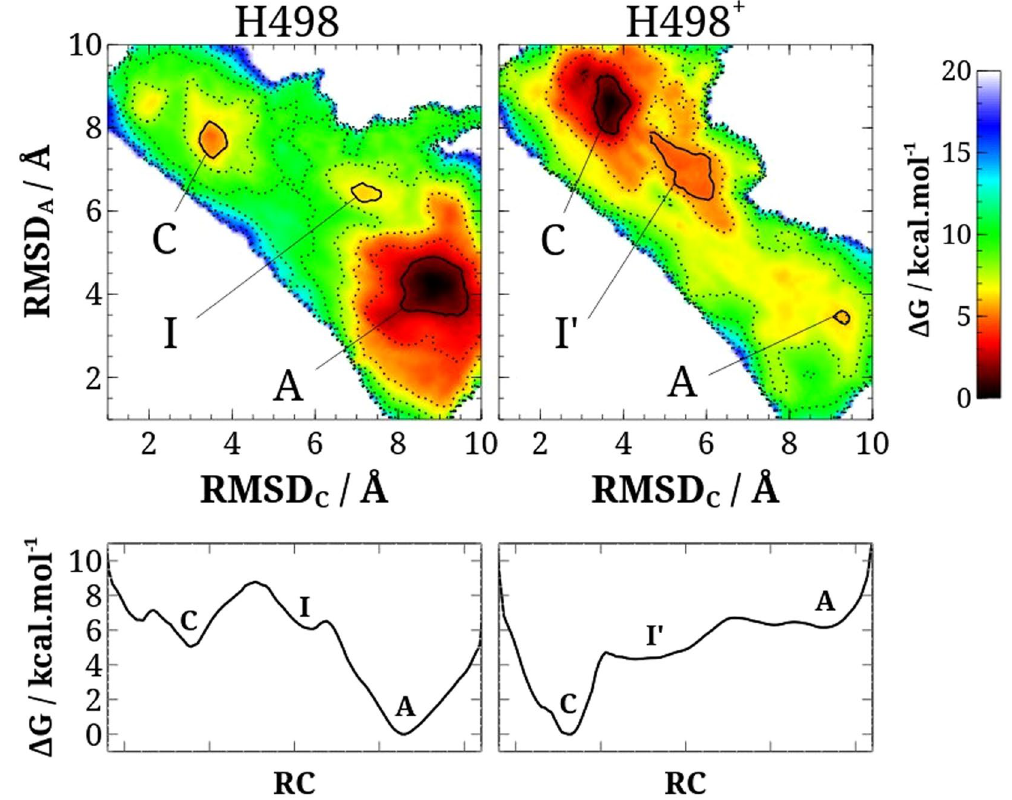
Figure 5. Free-energy landscape of H12 conformation: ( A ) Free-energy maps of H498e and H498 + protonation states of ER β LBD-E2 structure. The free energy values are shown in a color scale and dashed contour lines (ranges of 2 kcal. mol − 1 ). The regions of global and local minimum free-energy are highlighted with solid lines and identified as: alternative-like conformations ( A ), canonical-like conformations ( C ) and intermediates (I). ( B ) Minimum free-energy paths along a generalized reaction coordinate (RC) of H498e and H498 + protonation states of ER β LBD-E2 structures, obtained from the free-energy